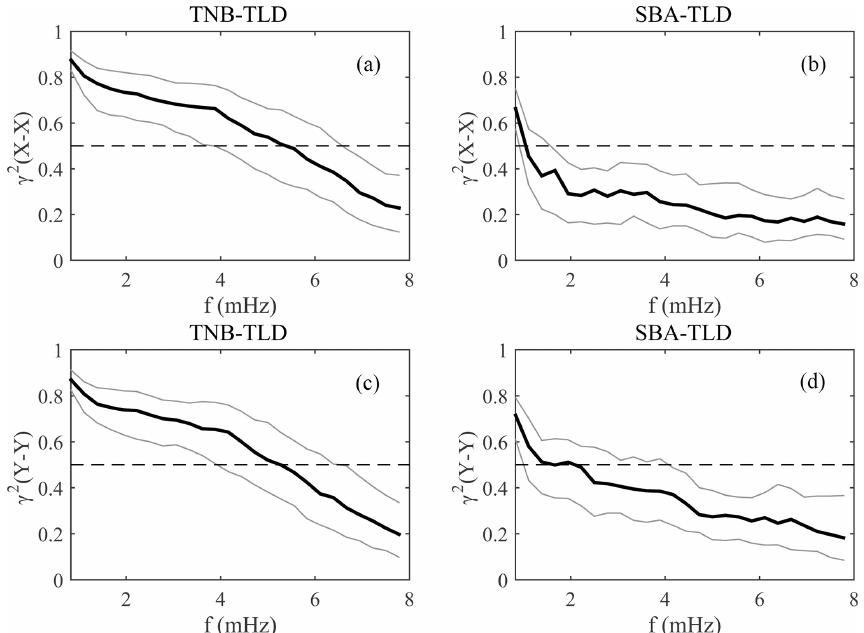
Figure 5. The coherence between horizontal homologous components at reference and coastal stations as a function of frequency. The horizontal bar indicates the 99% confidence level.